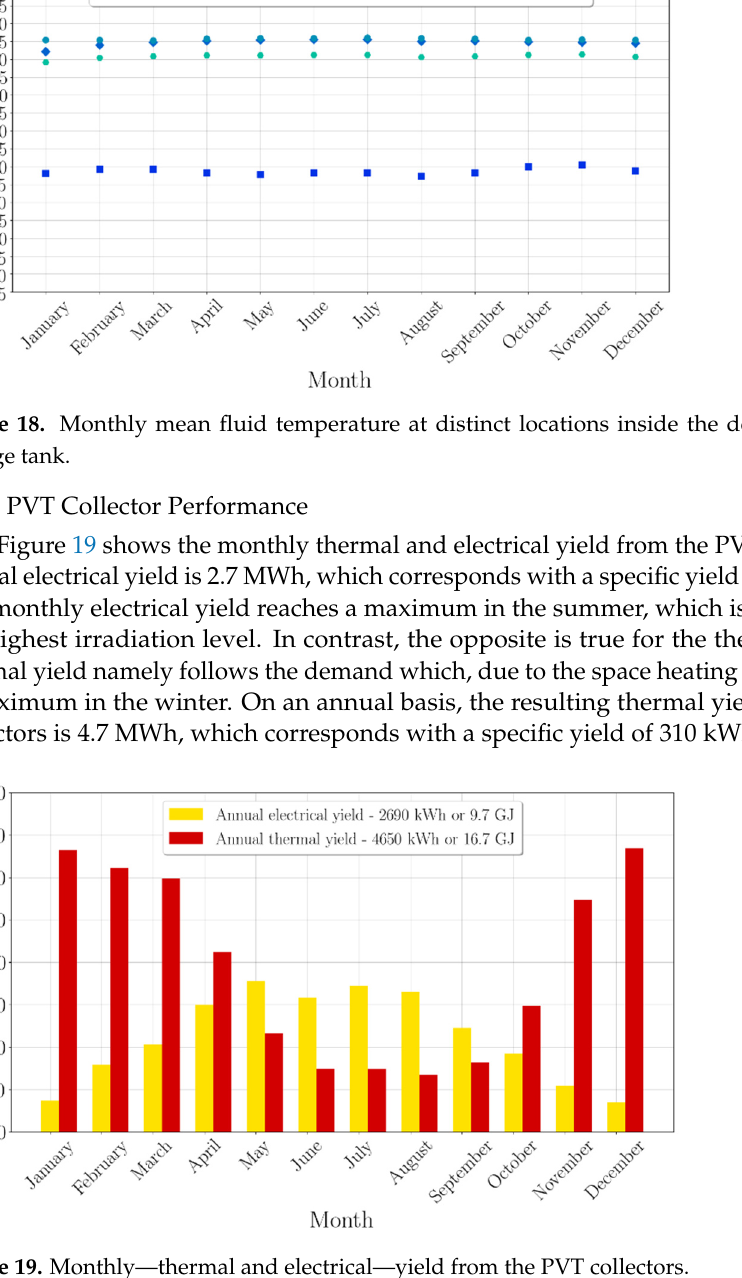
Figure 19. Monthly—thermal and electrical—yield from the PVT collectors.